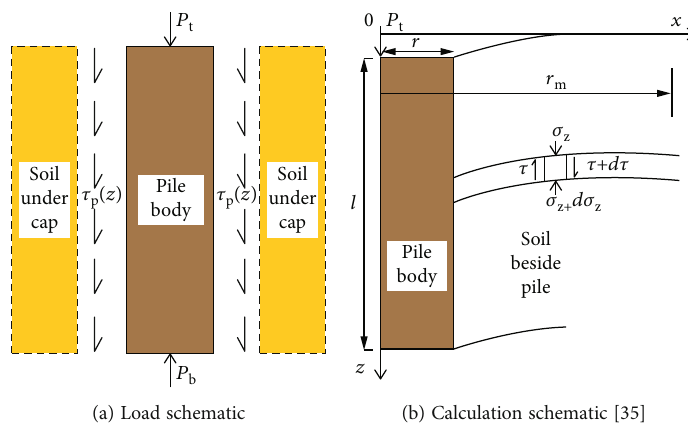
Figure 3: Calculation schematic diagram of P